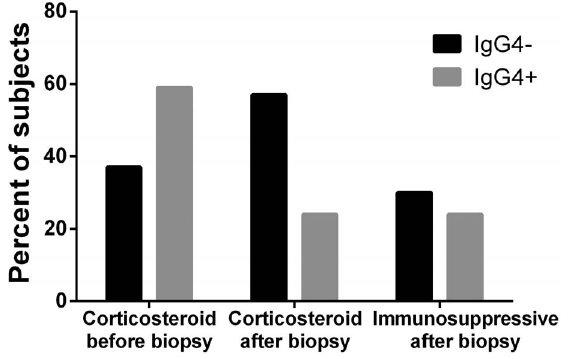
Figure 2. Patients with NSOI, GPA or sarcoidosis with at least 10 IgG4 + PC/hpf were not more likely to be treated with corticosteroid or other immunosuppressive therapy. These results are based on chi square testing for 30 IgG4- and 17 IgG4 + subjects for whom treatment data were available.